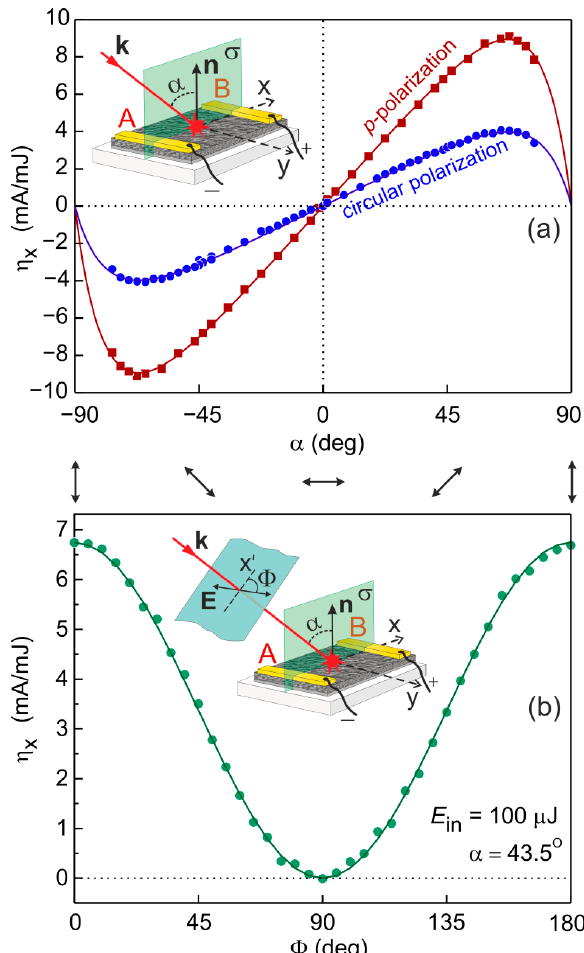
Figure 1. The light to longitudinal photocurrent conversion coefficient η x as a function of ( a ) the light incidence angle α on the film at linear ( p -polarization) and circular polarizations (points denote experimental results, curves denote fitting with η x = 35.37sin2 α / ( 1.76cos α + 1 ) 2 and 15.68sin2 α / ( 1.75cos α + 1 ) 2 for linear and circular polarization, respectively) and ( b ) the azimuth of the polarization plane Φ at α = 43.5 ◦ (dots denote experimental results, curve denotes fitting with η x ( Φ ) = 6.7cos 2 Φ ; orientations of the polarization plane are shown at the top). The insets show the sketches of the experimental setups: k and E are the wave vector and the electric field vector of the incident radiation, respectively; σ is the plane of incidence; α is an angle of incidence; n is the normal to the film surface; A and B are the measuring electrodes; x, y are the axes of the rectangular coordinate system; the x and x (cid:48) axes lie in the σ plane (x (cid:48) ⊥ k , the x axis is perpendicular to the electrodes A and B ); Φ is the angle between the x (cid:48) and E . With linear polarization, the dependence of η x on the polarization azimuth Φ (the angle between the plane of polarization and the radiation incidence plane on the film σ )